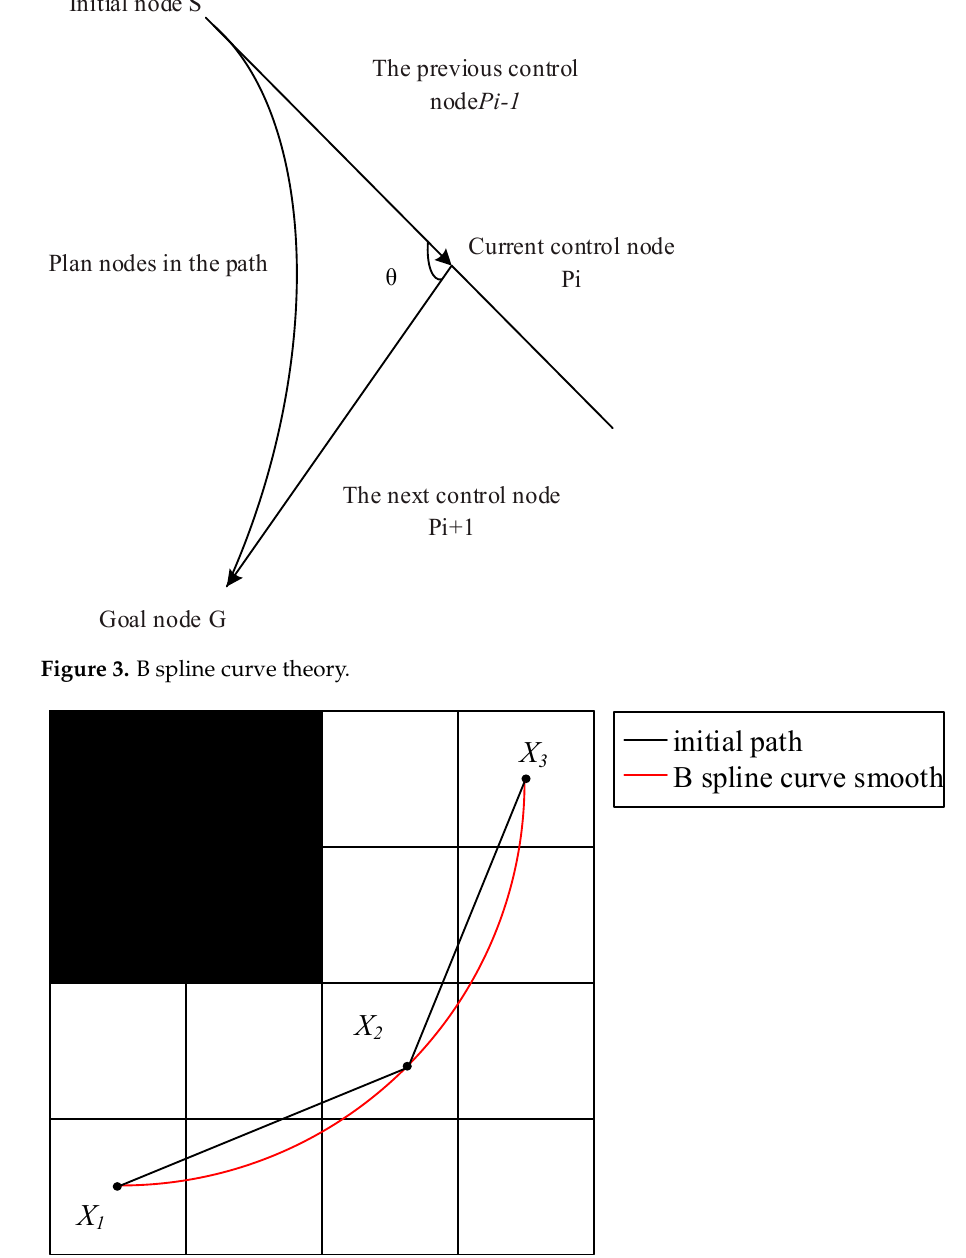
Figure 4. B spline curve